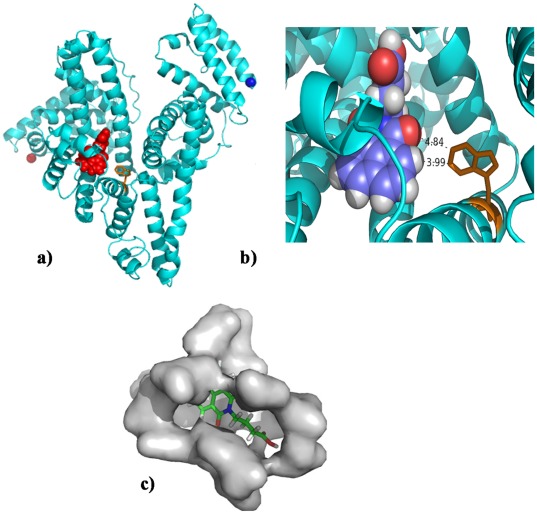
Cartoon representation of HSA with the bound virstatin (red).Trp214 is shown in golden sticks. In (a) the N- and the C-termini of the polypeptide chain are shown as red and blue balls, respectively. (b) Close-up view of virstatin (N is in blue, O in red, H is in grey and the rest are C atoms) with two short contacts with Trp214 shown. (c) The cavity corresponding to site I with bound virstatin. The details of the relative positions of the neighboring residues (Table 4) are shown in Figure S5. The figures are made with PYMOL (http://www.pymol.org).